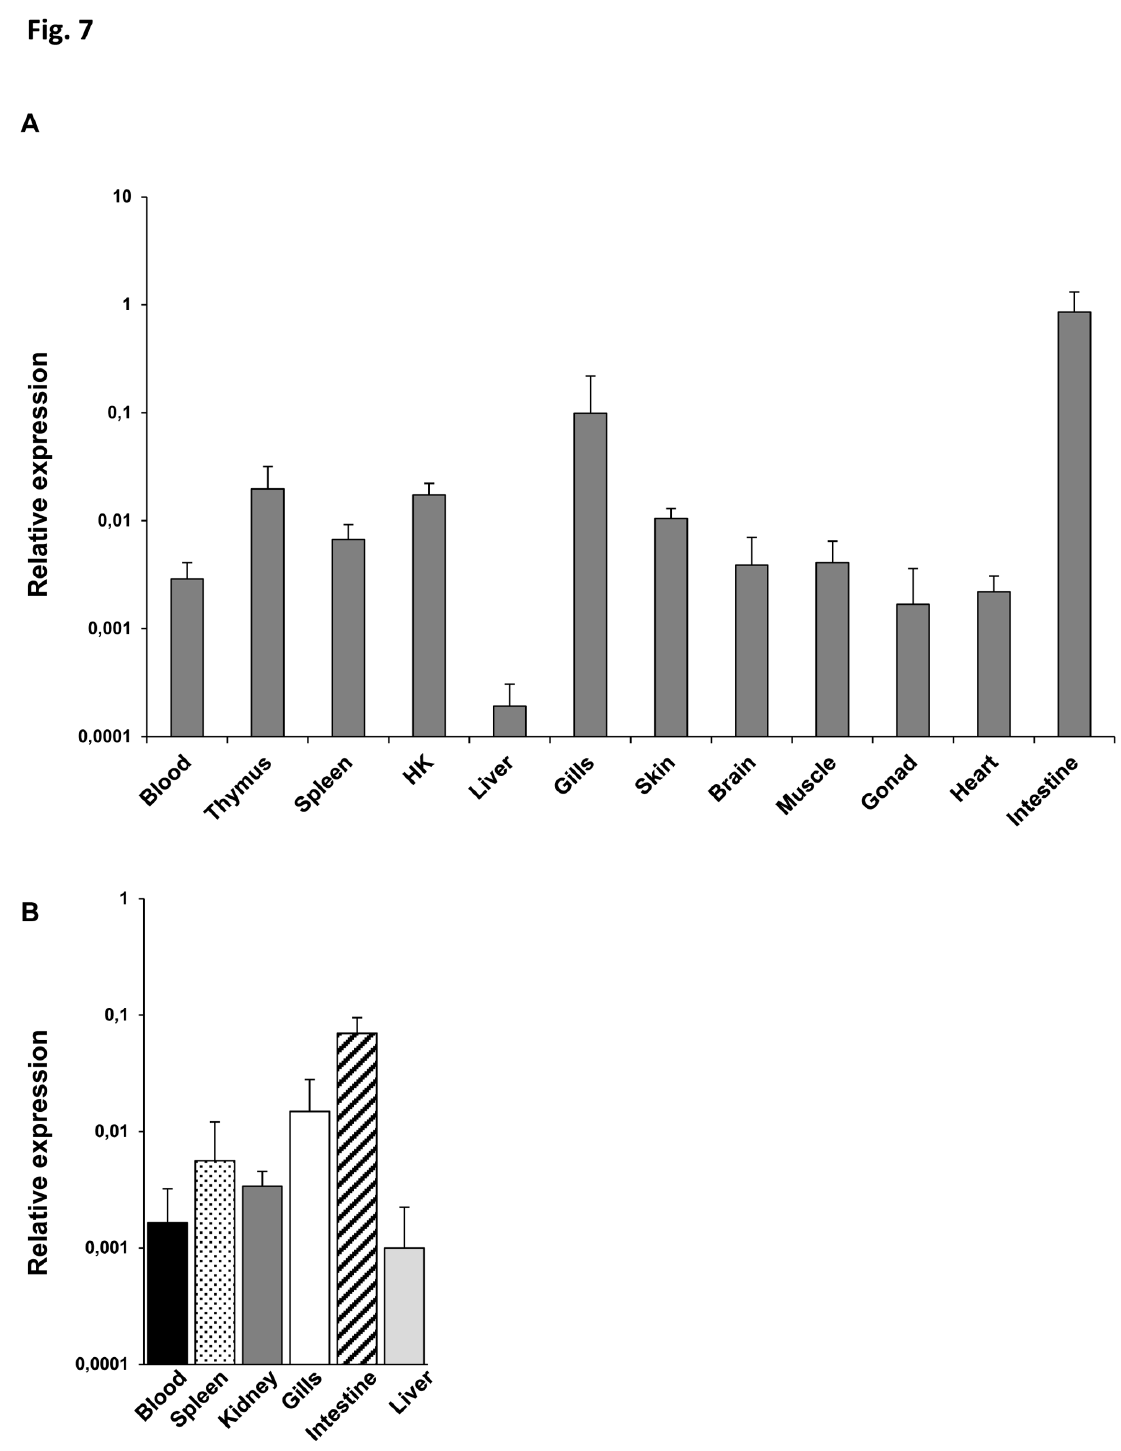
Figure 7. Levels of MS4A transcription in rainbow trout tissues and sorted IgM + cells. A. MS4A mRNA levels measured by real time PCR in different trout tissues. Data are shown as the mean gene expression relative to the expression of an endogenous control (EF-1α) ± SD obtained in 3 naive individuals. B. Levels of transcription of MS4A in sorted IgM + cells from blood, spleen, kidney, gills, intestine and liver. Results are shown as the mean gene expression relative to the expression of EF-1α ± SD for 5 independent experiments. doi: 10.1371/journal.pone.0082737.g007 PLOS ONE |